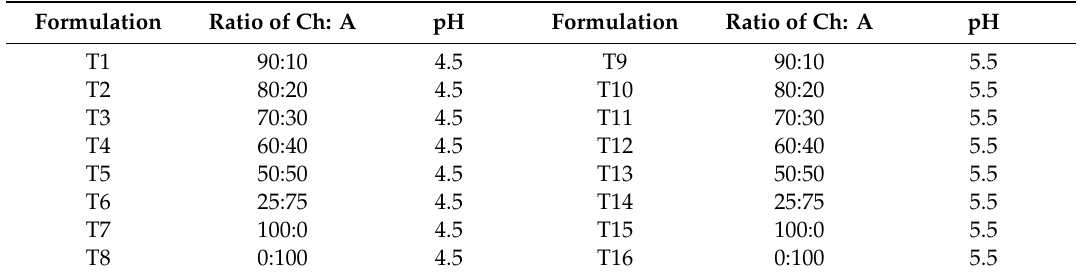
Table 1. Formulations with di ff erent ratios of chitosan (Ch): Aloe vera gel